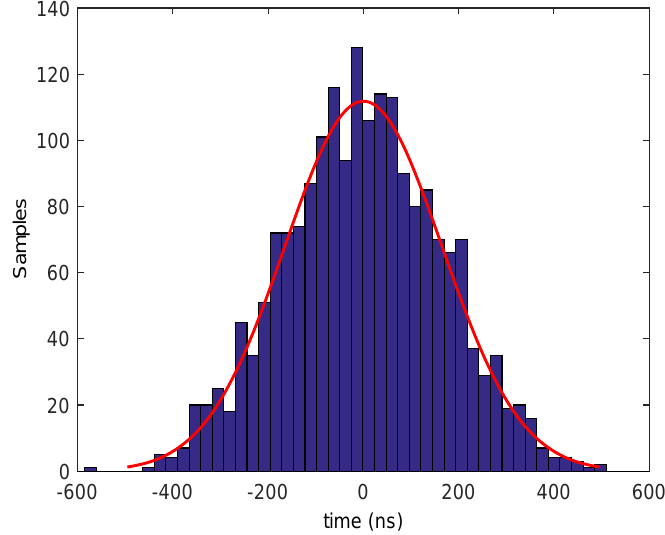
Figure 5. Distribution of time delay synchronization between TelosB motes (experimental measurements) and associated Probability Density